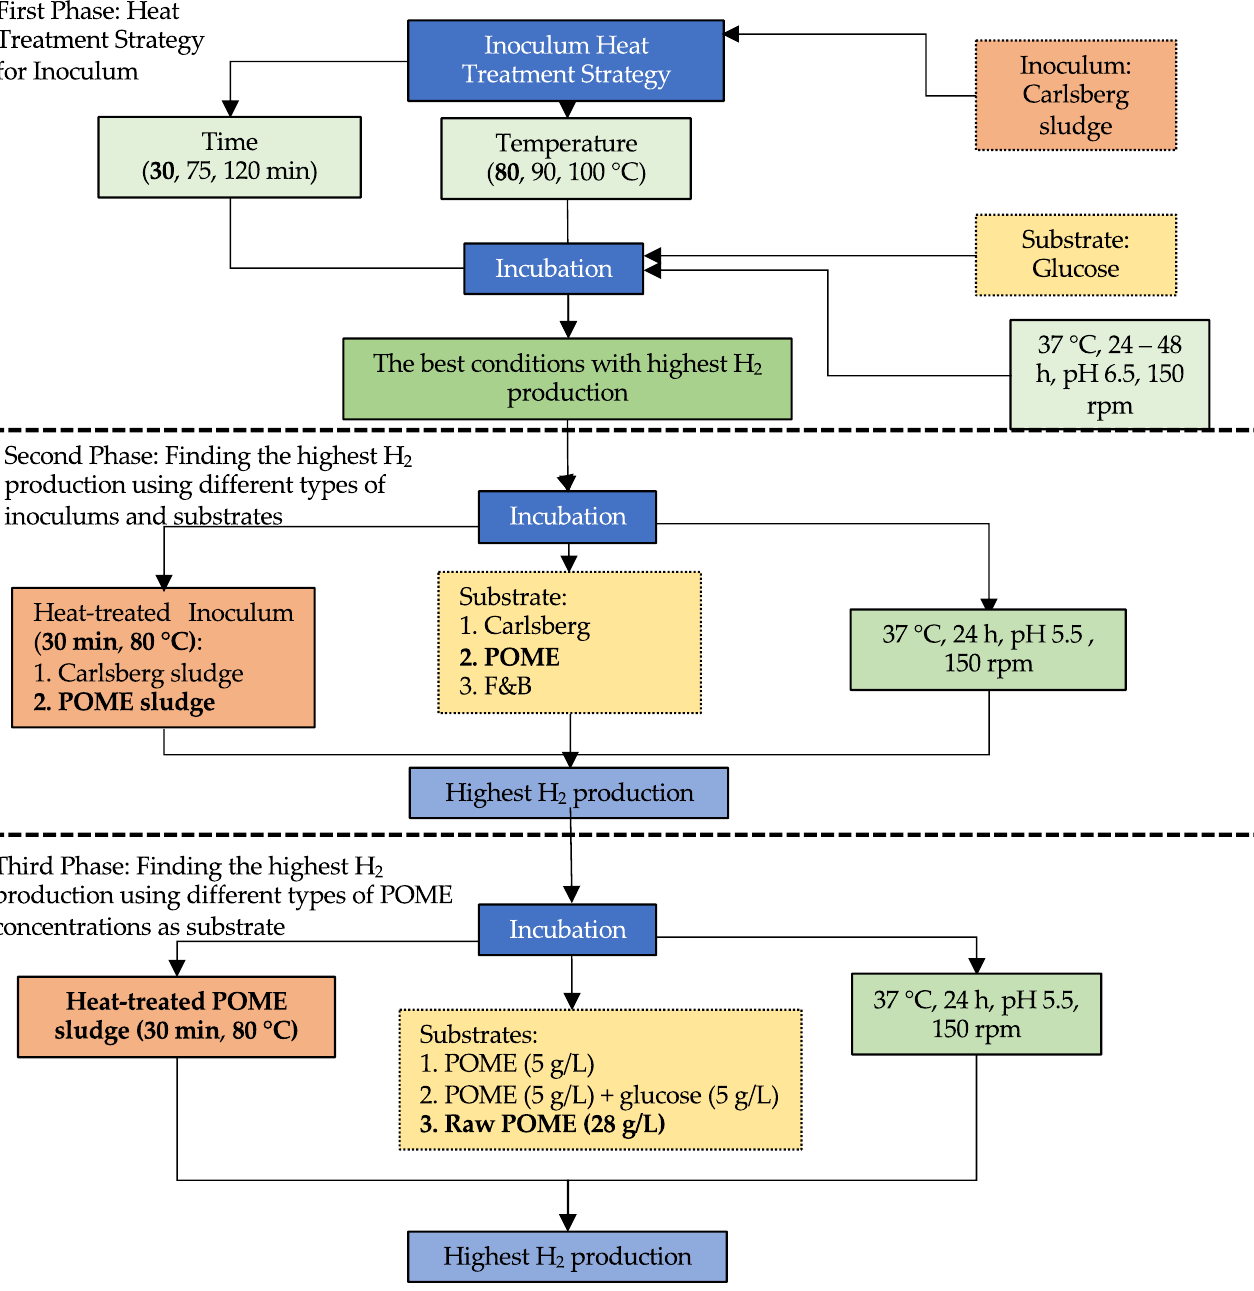
Figure 2. A summary of a step-by-step optimization strategy used in this study for biohydrogen production potential. (H 2 = biohydrogen)